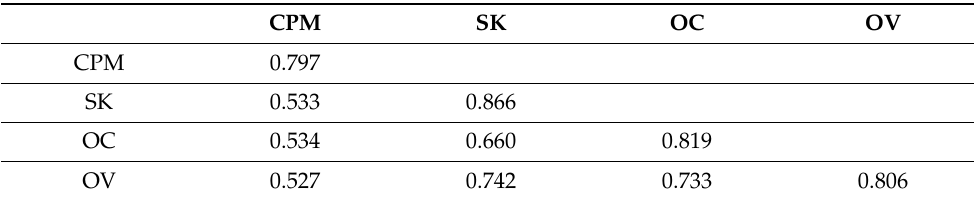
Table 3. Discriminant validity (Fornell–Larcker